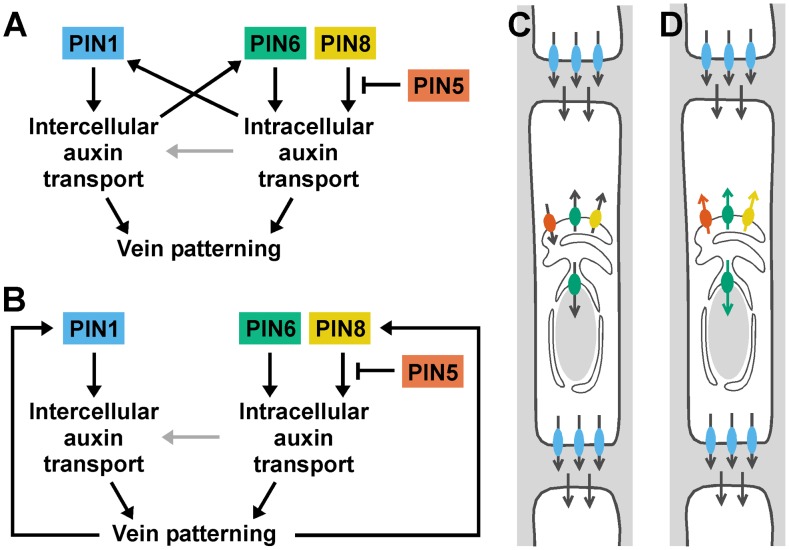
Summary and interpretation.(A,B) Two potential, non-mutually-exclusive regulatory circuits for PIN1 and PIN5/PIN6/PIN8 in vein patterning. Arrows indicate positive regulation; blunt-ended lines indicate negative regulation. Distinct functions of PIN1-mediated intercellular auxin transport and of PIN5/PIN6/PIN8-mediated intracellular auxin transport converge on vein patterning. Additionally, PIN1-mediated intercellular auxin transport could control vein patterning through regulation of PIN6 expression, and PIN5/PIN6/PIN8-mediated intracellular auxin transport could control vein patterning through regulation of PIN1 expression (A). Alternatively, vein patterning could feed back on expression of PIN1 and PIN6 (B). PIN1-independent functions of PIN5/PIN6/PIN8-mediated intracellular auxin transport in vein patterning could include intercellular auxin transport by a mechanism nonhomologous to that used by PM-localized PIN proteins [63] (grey arrows). (C,D) Localization of PIN1 (blue) at the basal plasma membrane and of PIN5 (orange), PIN6 (green) and PIN8 (yellow) at the endoplasmic reticulum/nuclear envelope (ER/NE) of vascular cells. For simplicity, PIN5, PIN6 and PIN8 are shown to be expressed in the same cell, only PIN6 is shown to be also localized at the NE, and localization of AUX/LAX [30], ABCB/PGP/MDR [32] and PILS [31] auxin transporters is not shown. Arrows indicate presumed directions of auxin transport. Antagonism between pin5 and pin6;8 in vein patterning could reflect opposite directions in which PIN5 and PIN6/PIN8 transport auxin (C), different abilities of PIN5 and PIN6/PIN8 to transport different auxins or auxin conjugates (orange, green and yellow arrows) (D; for simplicity, the mirror-image scenario, i.e. transport to the ER/NE lumen, is not shown), or varied combinations of the two. See text for additional details.